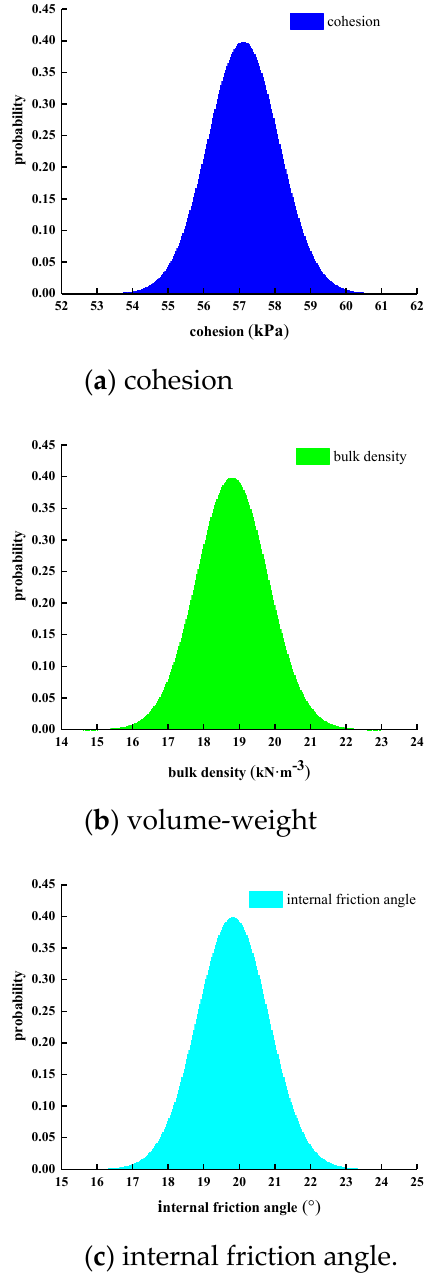
Figure 11. Probability density function distribution of manganese slag parameters.